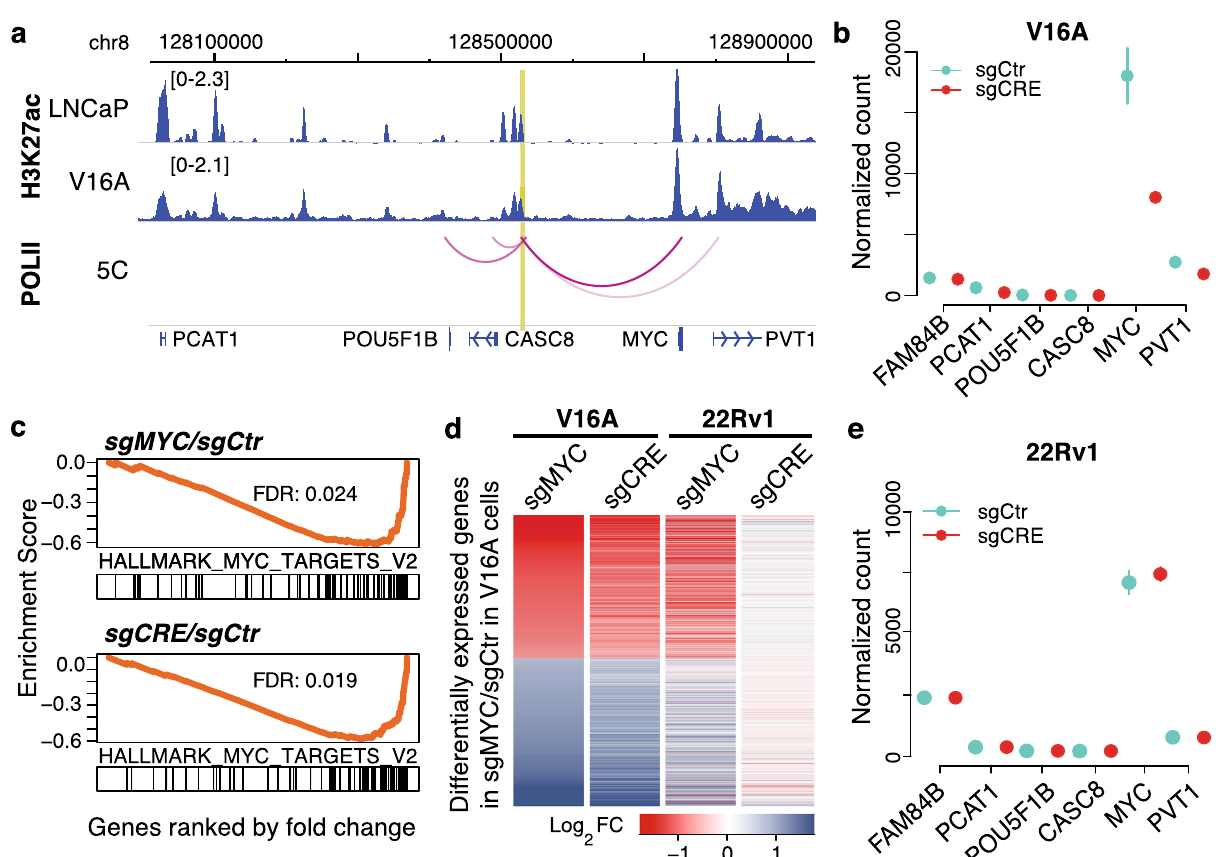
Fig. 3 The rCRE chr8:128531465 – 128532265 regulates MYC in V16A but not in 22Rv1 cells. a The top two tracks demonstrate the H3K27ac ChIP-seq signal in LNCaP and V16A cells. The arc track represents the interactions between this rCRE and neighboring promoter regions as determined by ENCODE POLII 5C data in LNCaP cells. The intensity of the arc color represents the interaction strength. The bottom track represents the RefSeq gene annotation. The chromosomal positions are of the genome assembly Hg19. b Expression of neighboring genes as determined by RNA-seq upon repression of the rCRE chr8:128531465 – -128532665 by dCas9-KRAB in V16A cells. The data are shown in mean ± s.d. ( n = 2). Source data are provided as a Source Data fi le. c Gene set enrichment analysis shows that the hallmark MYC target genes (MSigDB H collection) are most overrepresented among the genes downregulated by repression of the MYC promoter (upper panel) or rs11986220-CRE (lower panel). See Supplementary Fig. 3 for overall gene set enrichment analysis. d Changes in transcriptome-wide gene expression upon repression of the rCRE (by sgCRE) and the MYC promoter region (by sgMYC) in V16A and 22Rv1 cells. Only the genes differentially expressed (FDR < 0.1 and fold change >1.5, negative binomial test) upon MYC promoter repression (sgMYC) in dCas9-KRAB V16A cells are shown. The genes are sorted by fold change in V16A cells. FC fold change. e Expression of neighboring genes as determined by RNA-seq upon repression of the rCRE by dCas9-KRAB in 22Rv1 cells. The data are shown in mean ± s.d. ( n = 2). Source data are provided as a Source Data fi